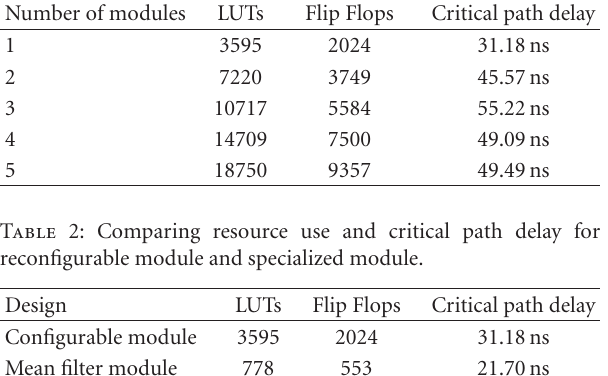
Figure 8: Size multiplication factor of a reconfigurable module compared to a specialized module for three applications